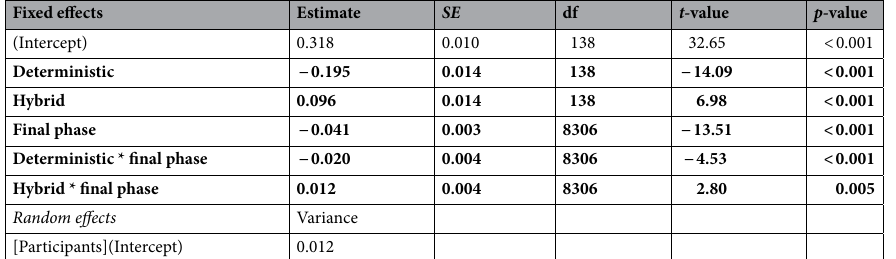
Table 4. Summary of the linear mixed-effects model testing the sensitivity to the optimal pump number in the predictable task phases (Model 4). Dependent variable: efficiency score (the difference of optimal minus actual pump number divided by the optimal pump number). This is determined for all balloons (irrespective of balloon burst). Coding scheme: sum coding. The reference levels of the factors were probabilistic condition and first phase. Significant effects are in bold (except the intercept). SE : standard